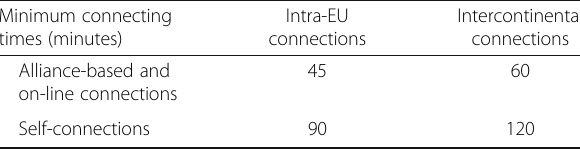
Table 1 Minimum connecting times for type of connections and for geographical areas Minimum connecting times (minutes)